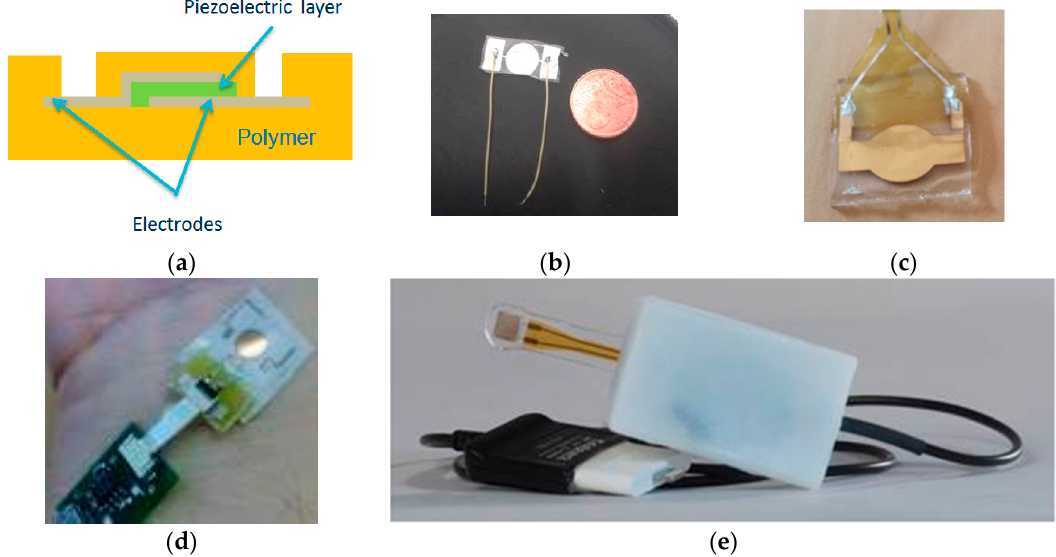
Figure 4. Sensor fabrication and evolutions; ( a ) side view; ( b ) first design; ( c ) second design embedded in parylene; ( d ) embedded with electronic circuits; ( e ) final version with a finger ring © images CNES.